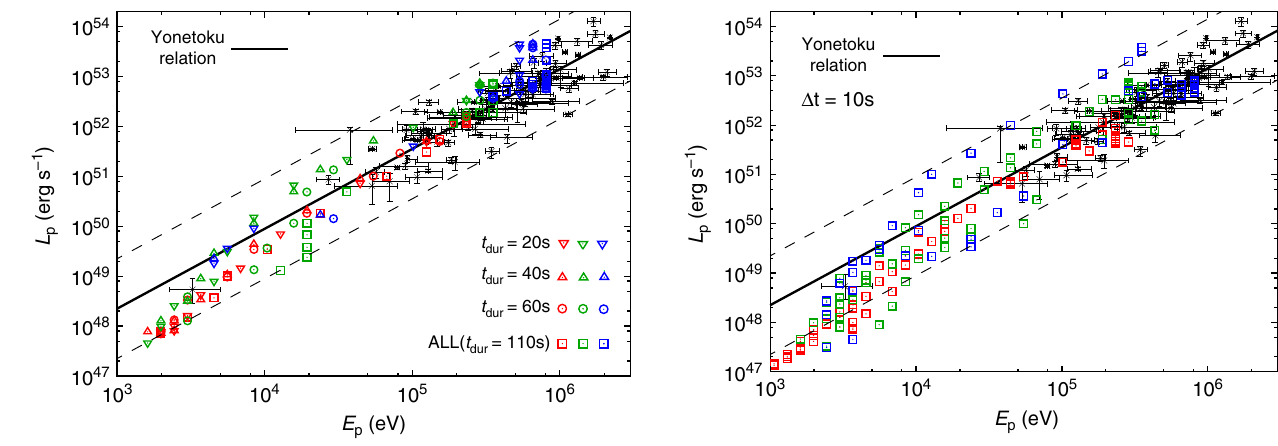
Fig. 3 Relation between spectral peak energy E p and peak luminosity L p . Results of our simulations are plotted with the observational data of 101 GRBs (gray points with error bars) and best- fi t curve of the Yonetoku relation (black solid line), L p = 10 52.43±0.037 × [ E p /355 keV] 1.60±0.082 erg s − 1 , taken from the literature 2 . The error bars of the observational data indicate 1- σ standard error for both E p and L p . Two dashed lines located below and above the best- fi t curve show the 3- σ systematic error regions of the Yonetoku relation. Symbol color indicates model, with red, green, and blue representing jet powers of L j = 10 49 , 10 50 , and 10 51 erg s − 1 , respectively. The inverted triangle, triangle, circle, and square plot the results obtained by sampling the emission up to durations t dur = 20, 40, 60, and 110 s, respectively. The considered range of viewing angle is 0° ≤ θ ≤ 11°, with 1° between successive points. Although the current results obs do not extend up to the bright end of the observed distribution, we expect that this population can be naturally produced by increasing the jet power and/or Lorentz factor, which shift the population toward higher energy and luminosity in the present study